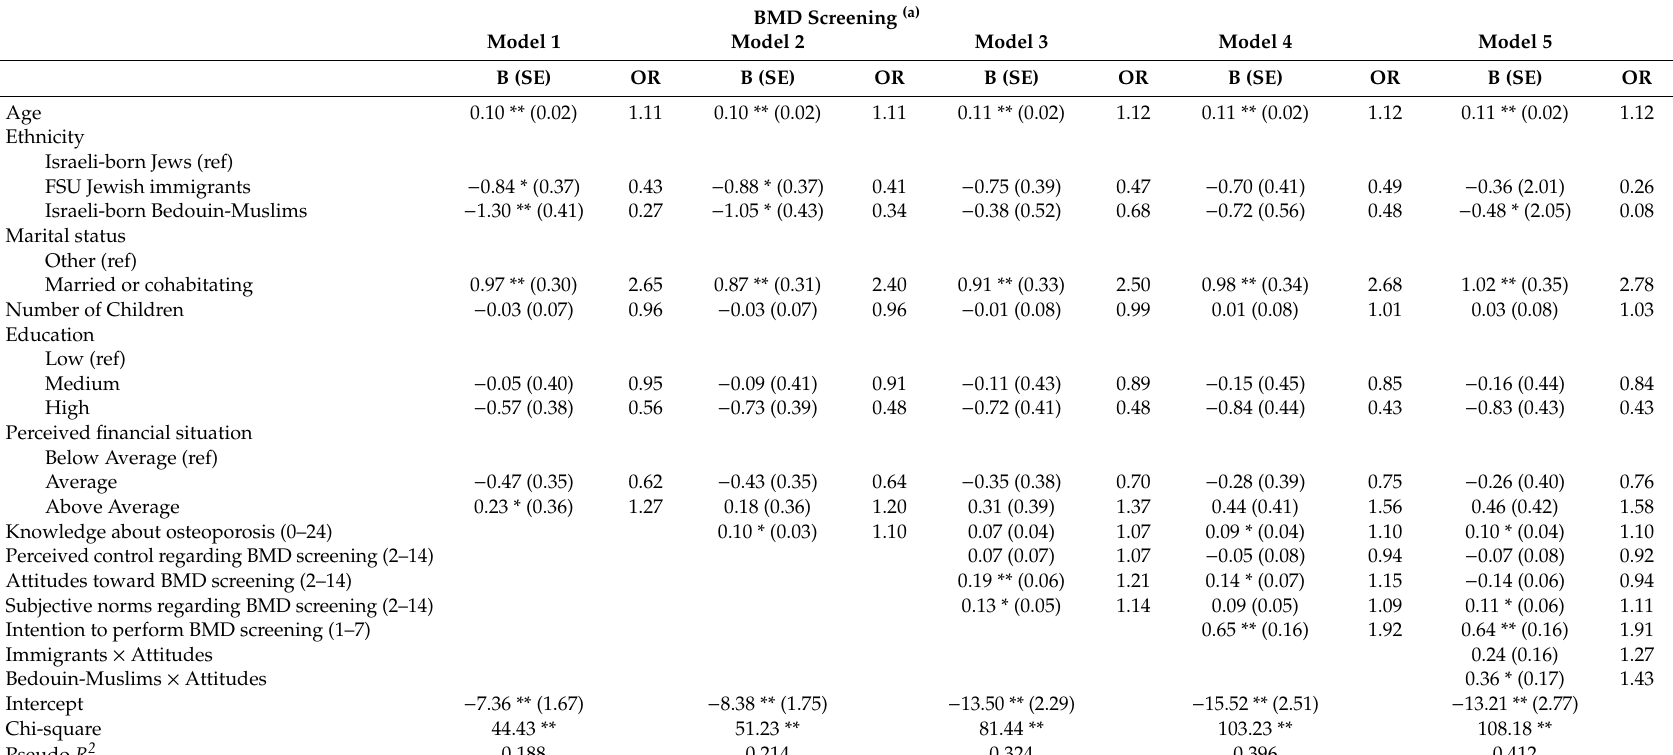
Table 4. Logistic regressions: Prediction of BMD screening behavior ( n =